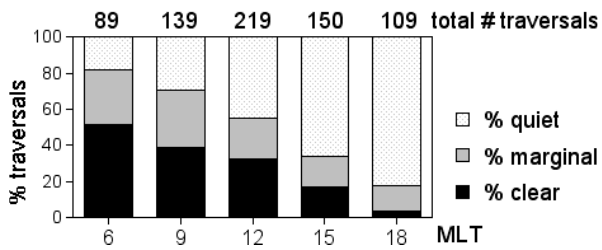
Fig. 4. Local time distribution of the wedge-like dispersion signa- ture observed by Viking (1986.3–1986.10). We took the probability of identifying phenomena during a traversal which covers at least > 67 ILat. The black bar (lower part), gray bar (middle part), and white bar (upper part) denote the traversals with a clear signature of structured dense sub-keV ions, with some structures but not strong signature, and with very weak or no signature, respectively. The number on the top of each bar is the total number of traversals in each MLT